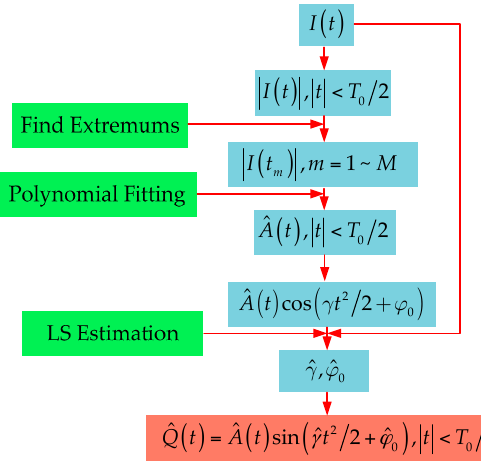
Figure 8. Fitting of the envelope in mainlobe.